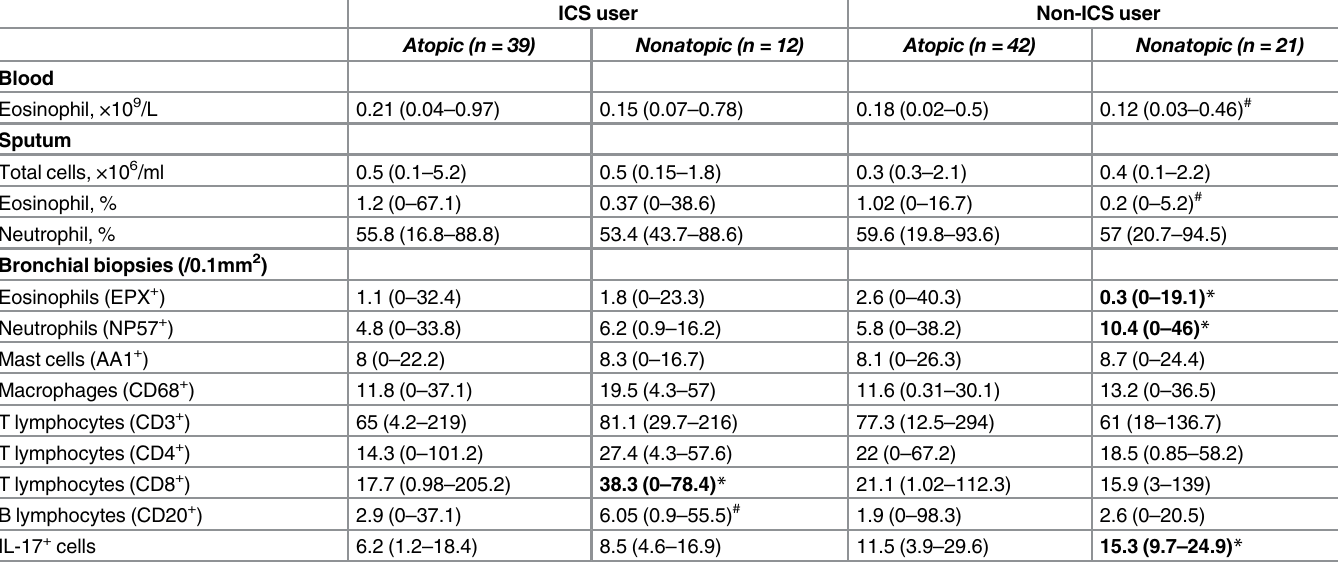
Table 2. Inflammation in atopic and nonatopic